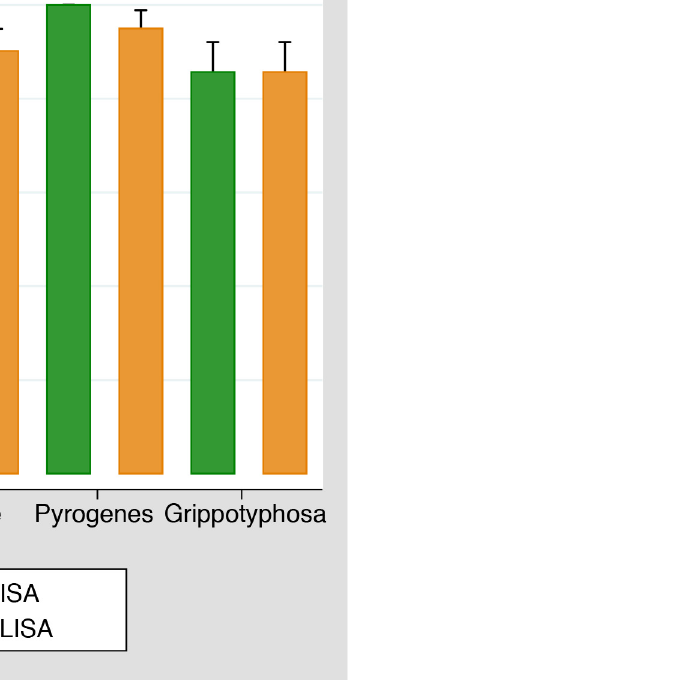
Fig 2. Comparison of sensitivity between serovars (N = 134). Vertical bars indicate 95% confidence